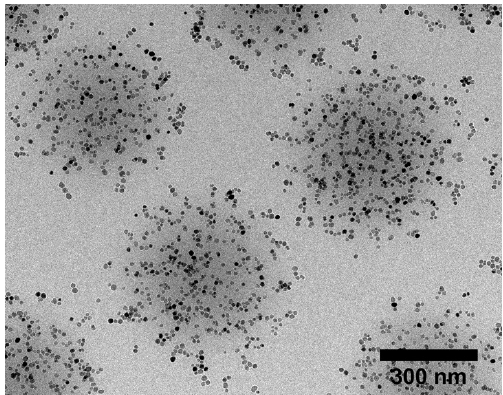
Figure 11. TEM image of P(NIPAM-co-acrylic acid) microgels with CoFe 2 O 4 MNP (coated with polyacrylic